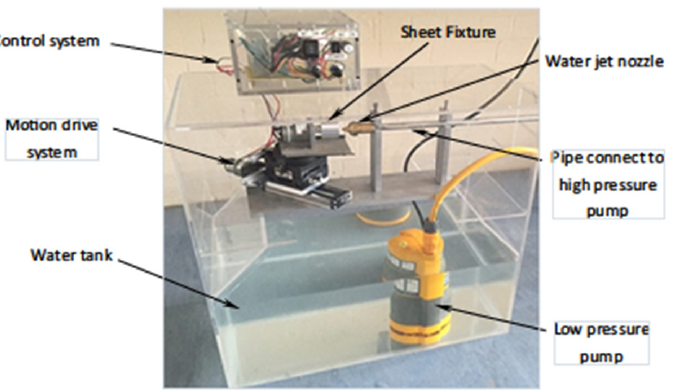
Figure 6. Device for incremental forming by water jet (adapted from Ref. [66] — this is an open